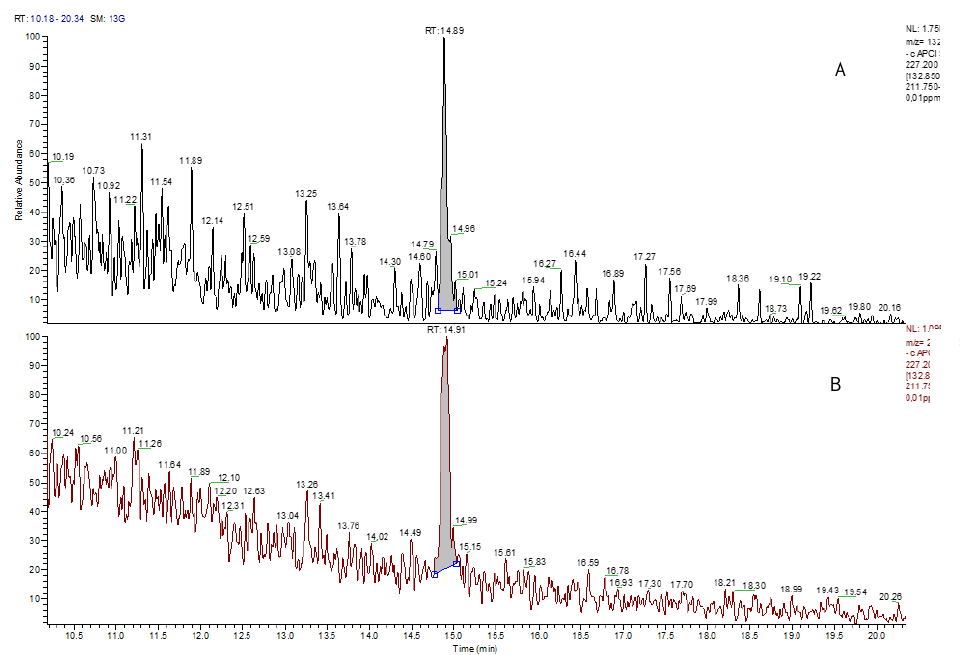
Figure 4. Chromatograms obtained by LC-MS / MS for the 0.01 mg kg − 1 standard solution of the BPA: ( A ) the transition 227.2 > 133.1 m / z; ( B ) the transition 227.2 > 212.1 m /